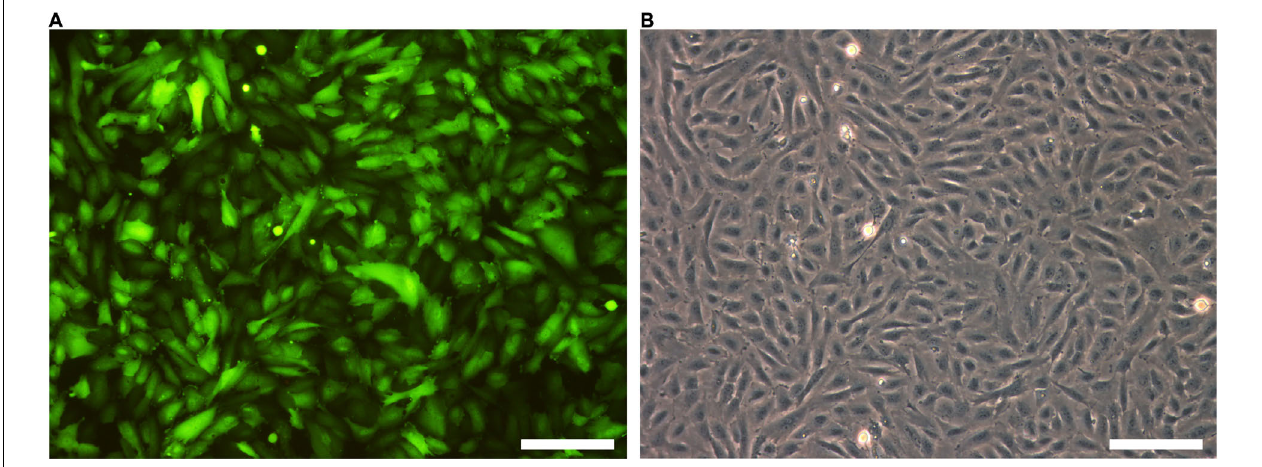
FIGURE 4 | GFP is highly expressed after lentiviral transduction. (A) GFP expression of LV-GFP transduced CPCs. (B) Bright field picture of CPCs. Scale bars represent 100 µ M, n = 5.